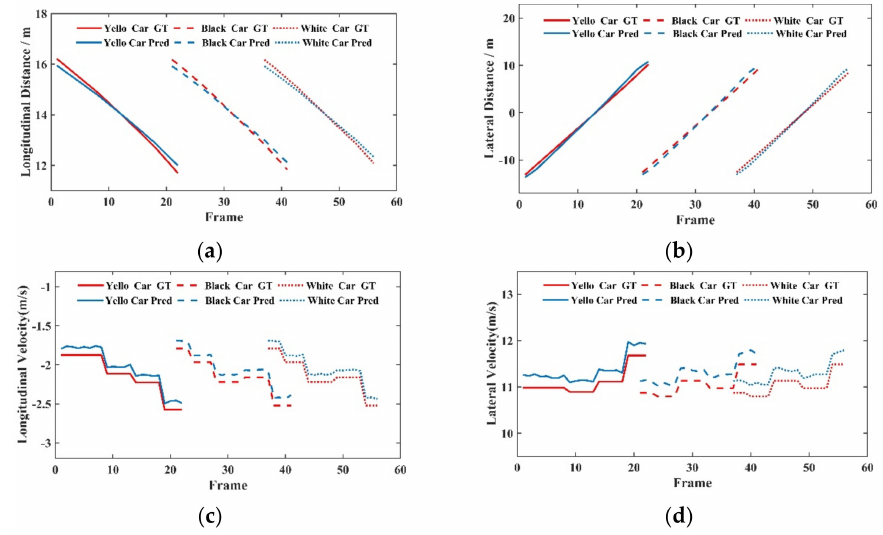
Figure 9. Real-time variation curves of the distance and speed of the target vehicle under the lateral incoming traffic scenario. ( a ) Longitudinal distance, ( b ) Lateral distance, ( c ) Longitudinal velocity, ( d ) Lateral velocity.